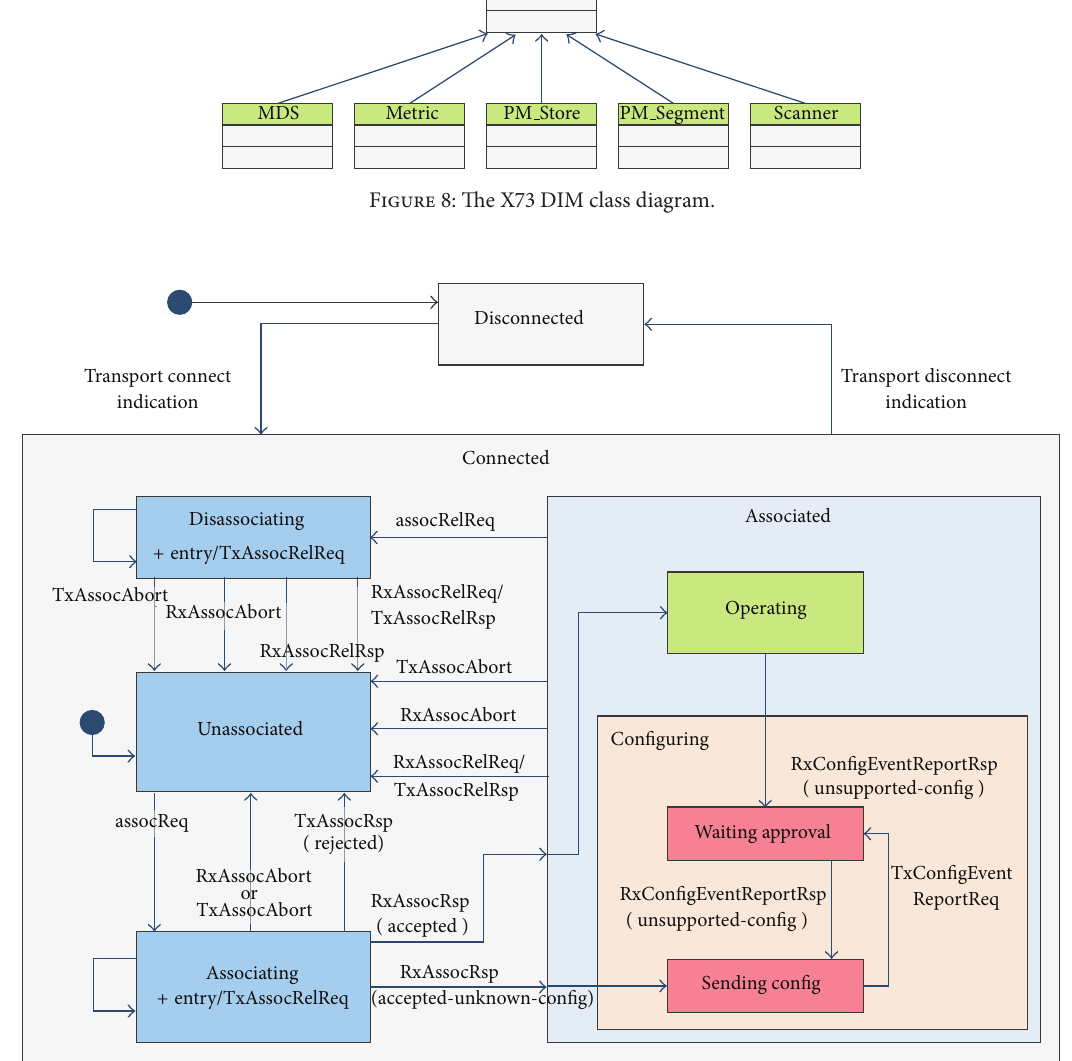
Figure 9: The state transition diagram of the X73 FSM